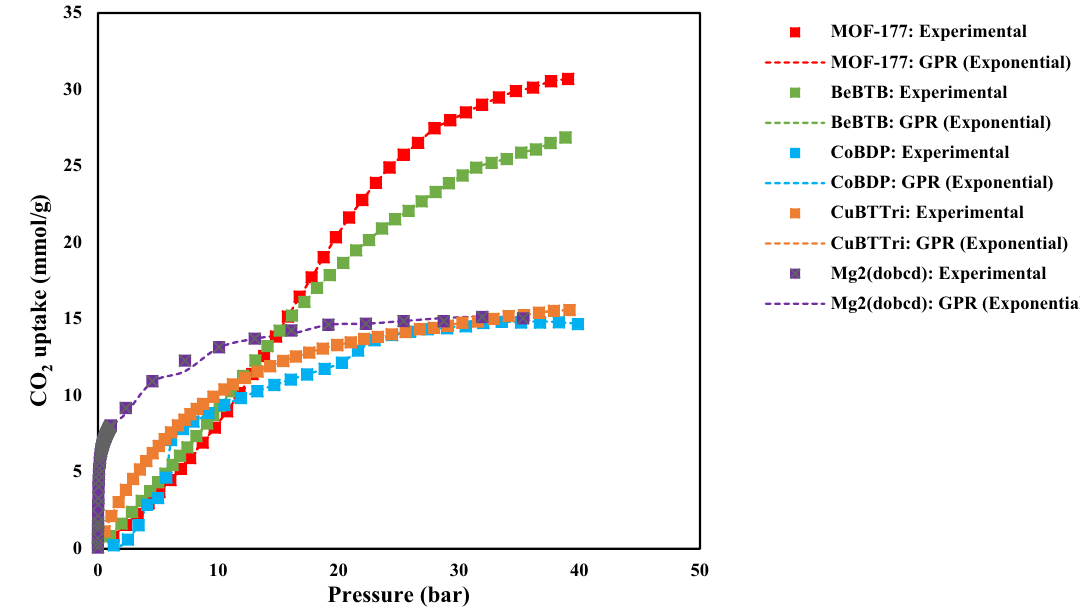
Figure 7. The CO 2 adsorption capacities of different MOFs at 313 K.